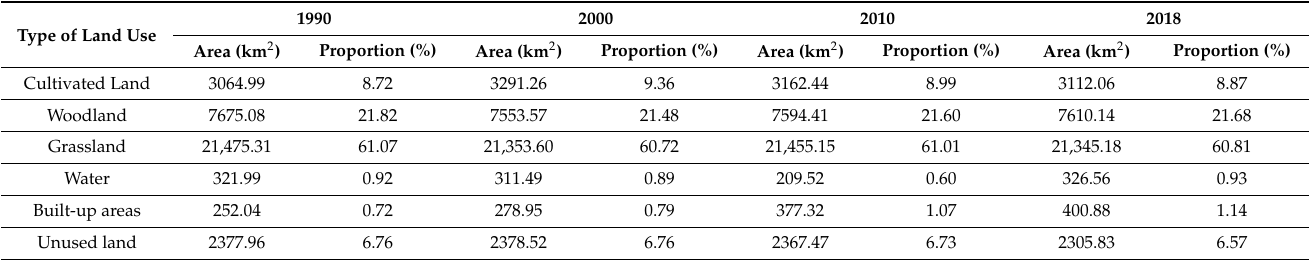
Table 1. The area and proportion of different land use in EFZUYR from 1990 to